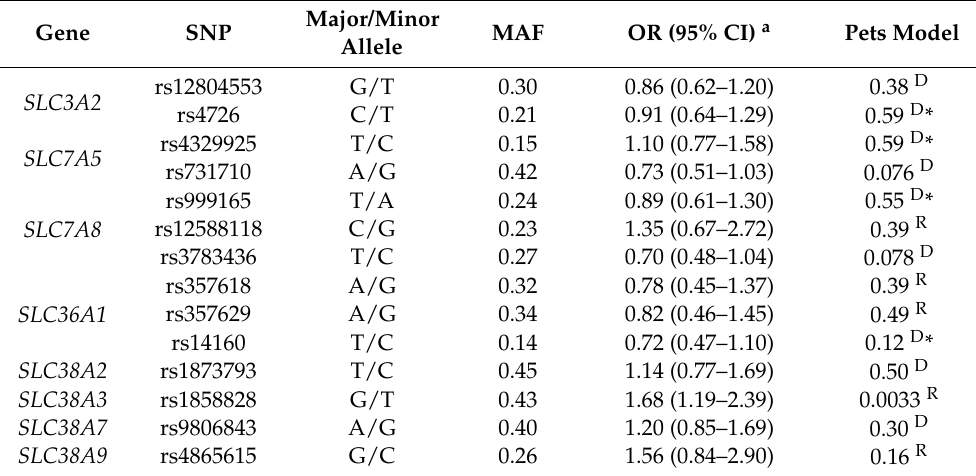
Table 2. Association analysis of AATs SNPs with Type 2 Diabetes.